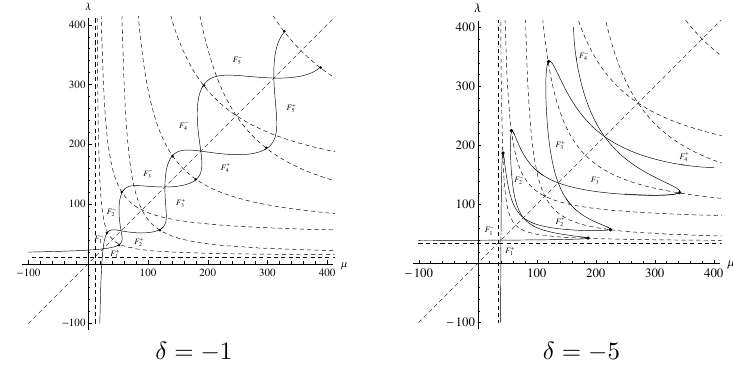
Figure 8. The spectrum of the problem (1.5), (1.6) for some negative δ values.